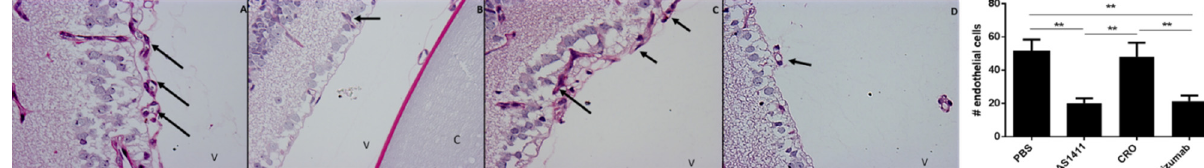
Figure 2. AS1411 reduces retinal angiogenesis in a proliferative retinopathy model. Micrographs of retinal histological slides using PAS staining (40 × ). Endothelial basement membranes were visualized by positive PAS staining. ( A ) PBS treated retinas developed the same amounts of neovascularization as the CRO group (black arrows). ( B ) AS1411 aptamer presented lower number of neovascular formation at the ILM and the retinal layers architecture was conserved. ( C ) CRO group presented similar amounts of neovascular as the PBS group. ( D ) Ranibizumab treated retinas developed lower number of neovascularization similar to AS1411 treated retinas. ( E ) The bars represent the mean and ( ± SE) of the endothelial cells per field. PBS and CRO groups had up to around 50 endothelial cells per field; while the mean number of AS1411 and Ranibizumab decreased around to 20 cells per field (a decreased of 2.5-fold compared to PBS and CRO groups). There was no difference between AS1411 aptamer and ranibizumab. Micrographs of 2 independent assays ( n = 5 of each assay). Bars = 20 µ m. ** p <